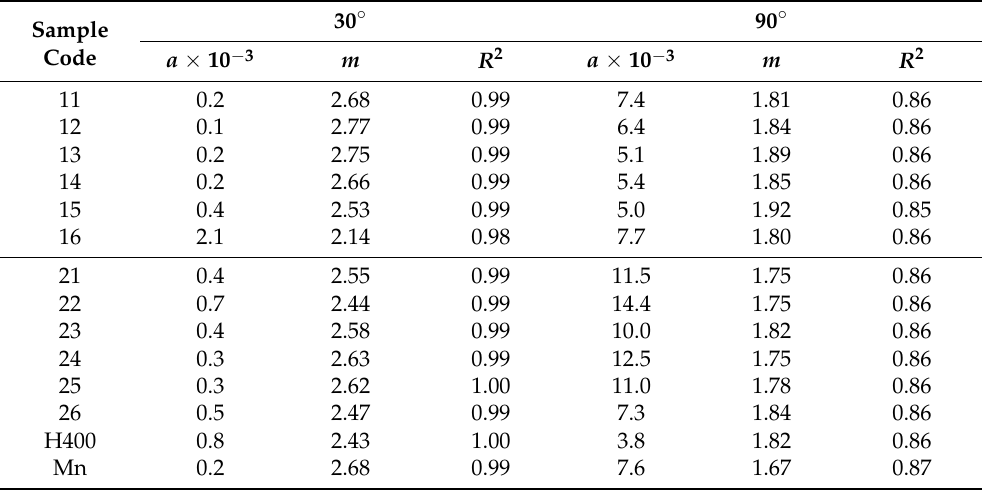
Table 5. Data for estimation of volumetric erosion rate of hardfacings and reference steels at impact angles of 30 ◦ and 90 ◦